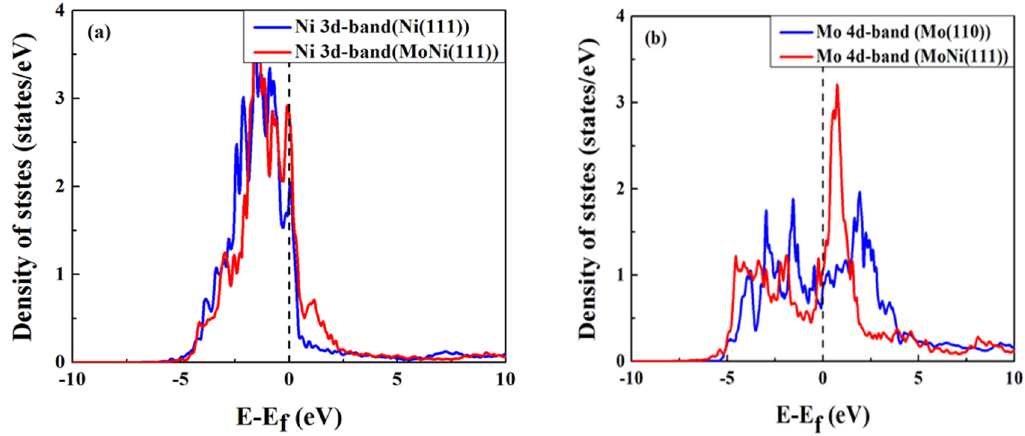
Figure 4. Calculated density of states (DOS) of the Mo and Ni atoms in the alloy and pure metal surfaces. ( a ) d ‐ band DOS of Ni atom in the top ‐ most atomic layer for the alloy and pure Ni surfaces; ( b ) d ‐ band DOS of Mo atom in the top ‐ most atomic layer for the alloy and pure Mo surfaces. The d ‐ band DOS for the Mo atom located at the top ‐ most surface layer, the second layer and the